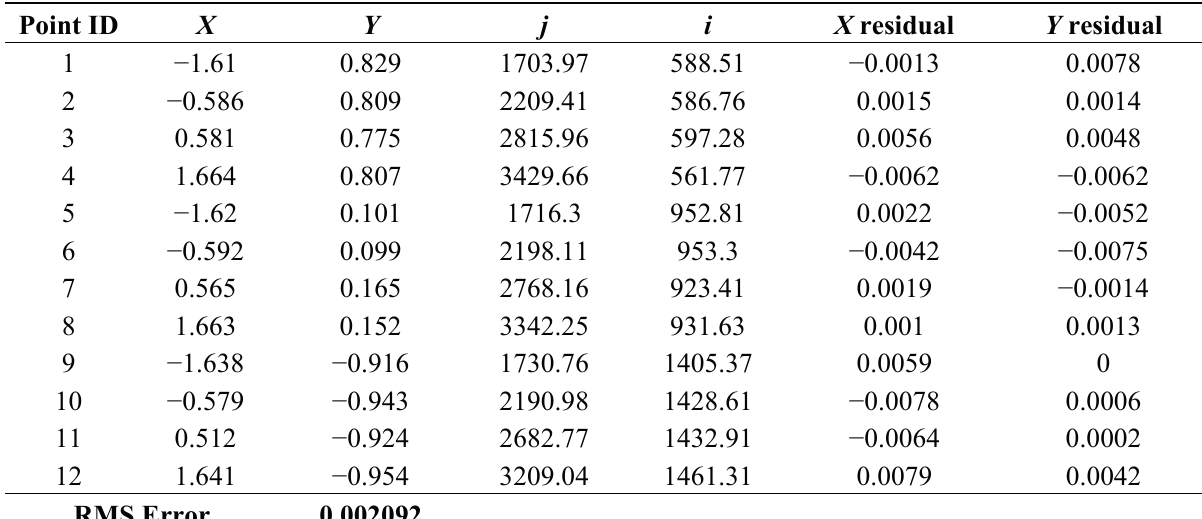
Table 8. Ground, image coordinates and their ground residuals of the undistorted GoPro image.